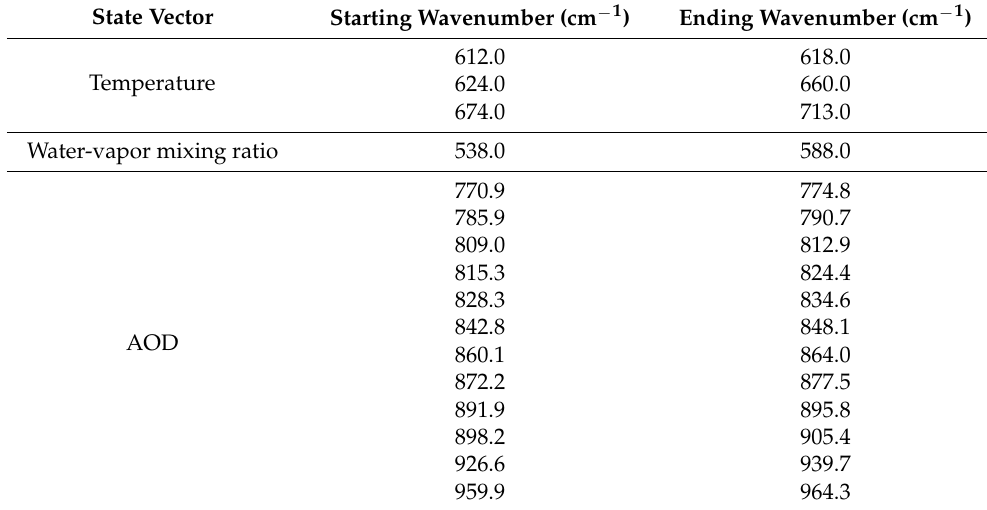
Table 2. Spectral region used in the retrieval of temperature, water-vapor mixing ratio, and AOD. State Vector Starting Wavenumber (cm − 1 ) Ending Wavenumber (cm − 1 ) 612.0 618.0 Temperature 624.0 660.0 674.0 713.0 Water-vapor mixing ratio 538.0